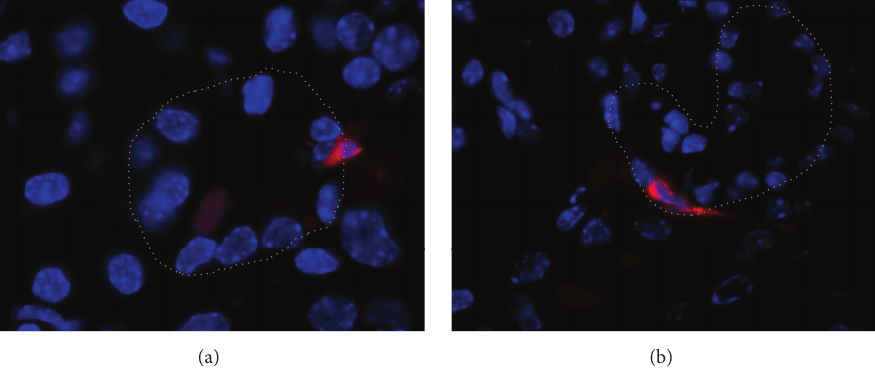
Figure 2: Representative images of kidney tissue in mice with cisplatin-induced AKI treated with DiI labeled MSCs (day 4). (a) DiI labeled MSCs (red fluorescence) in peritubular area. Original magnification: × 1000. (b) DiI labeled MSCs (red fluorescence) within proximal tubule epithelium. Original magnification: × 1000. Nuclei are stained with DAPI (blue fluorescence). Basal lamina of proximal tubule is marked with a gray line.